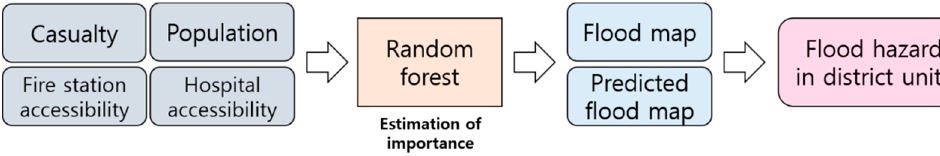
Figure 2. Flow Chart for flood hazard analysis.